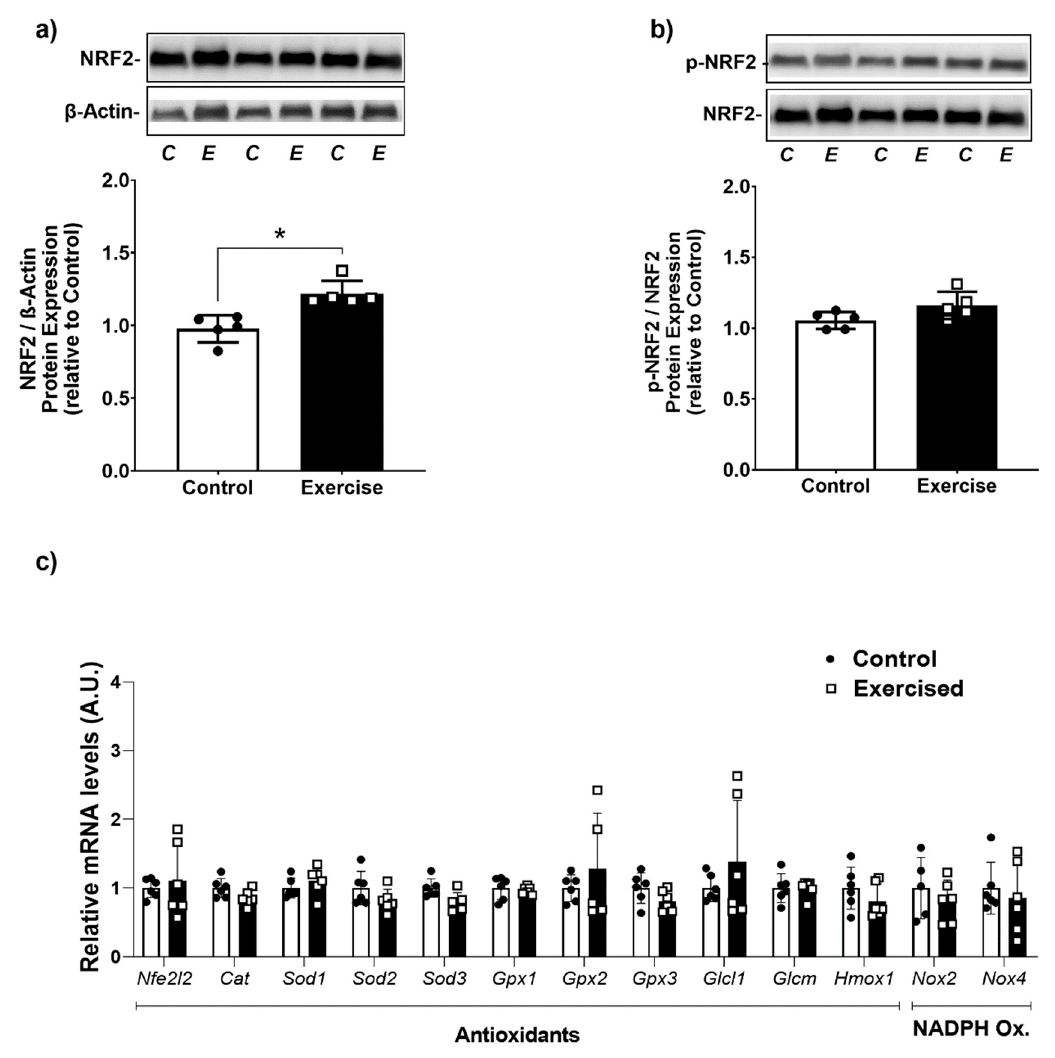
Figure 5. NRF2 was increased by aerobic exercise in retroperitoneal WAT. Total ( a ) and phosphor- ylated levels ( b ) of NRF2 protein-( n = 5 animals/group); ( c ) mRNA levels of pro and antioxidant